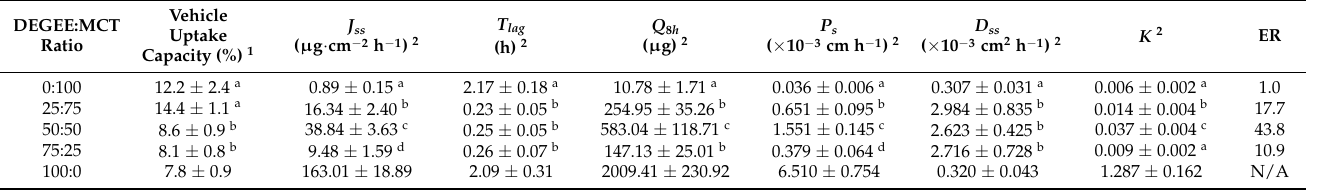
Table 4. Vehicle uptake capacity of mucosa and ex vivo permeation parameters of CBD with DEGEE:MCT binary